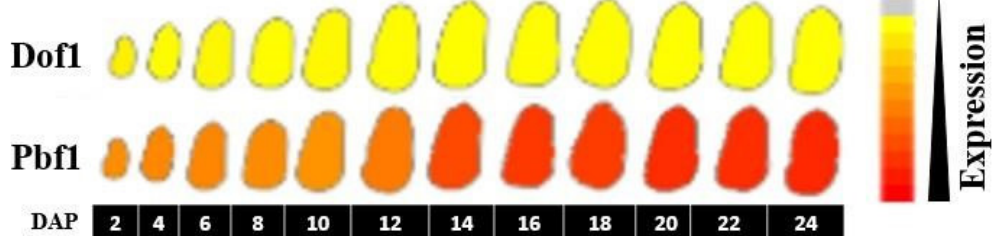
Figure 2. Expression profile of Dof1 and Pbf1 genes. Gene expression of Dof1 and Pbf1 in seed at various Days after Pollination (DAP) is depicted, data being retrieved from the MaizeGDB database. The expression scale is shown on the right, with dark red indicating the highest expression.